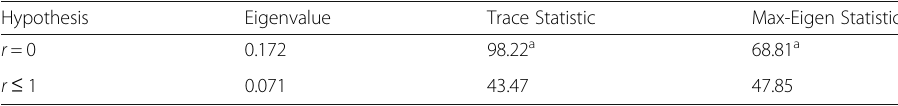
Table 3 Johansen Cointegration Test Hypothesis